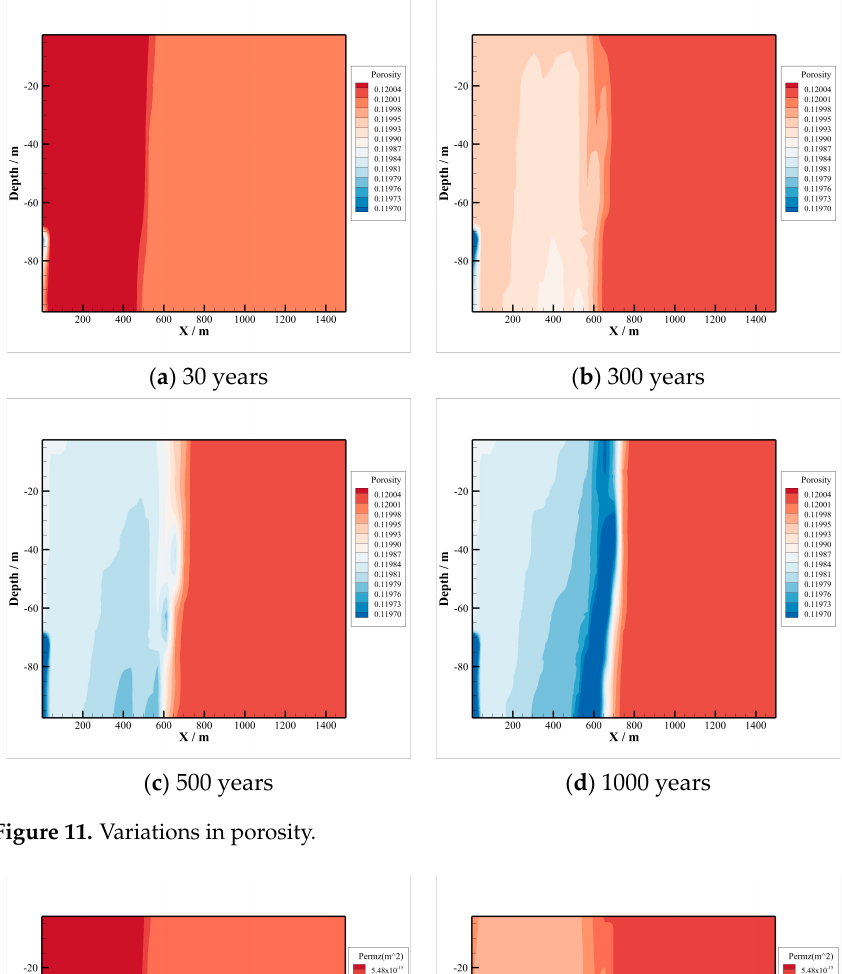
Figure 11. Variations in porosity.